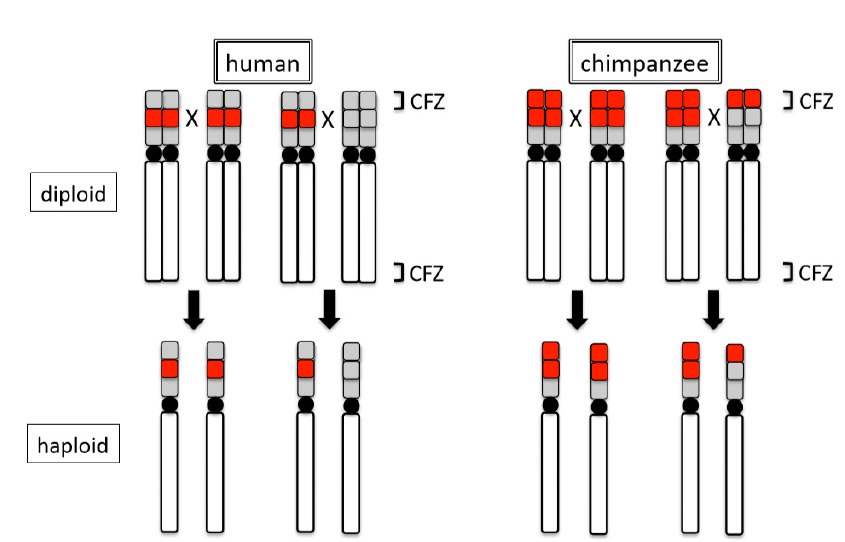
Figure 4. Difference in recombination at NOR loci between human and chimpanzee. Red blocks represent rDNA arrays. Grey blocks represent non-rDNA repeat arrays. CFZ: chiasma-free zone. ‘X’ indicates an assumed recombination site. Black arrows show possible recombinants. Black circles represent centromeres.